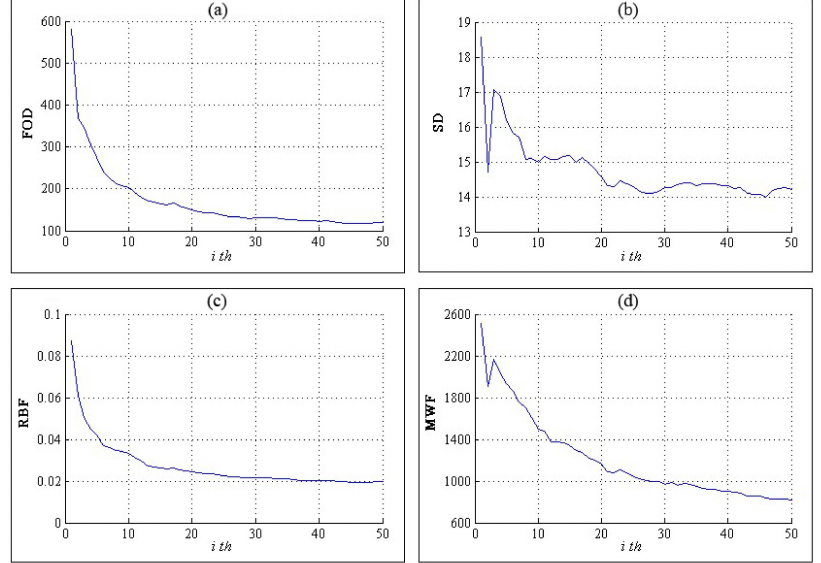
Figure 11. Comparison of indices obtained using overlay runoff matrix. The symbol i is the column number of the overlay runoff matrix. ( a ) the FOD index; ( b ) the SD index; ( c ) the RBF index; ( d ) the MWF